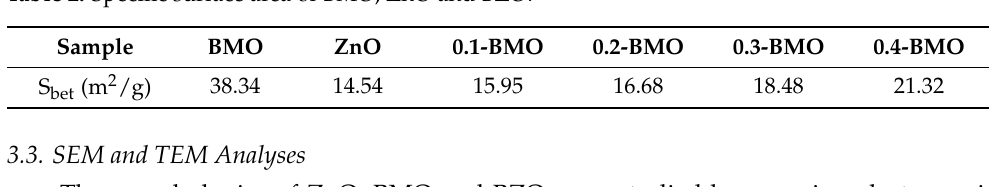
Figure 2. Nitrogen adsorption-desorption isotherms of BMO, ZnO, and BZO catalysts. Table 2. Specific surface area of BMO, ZnO and